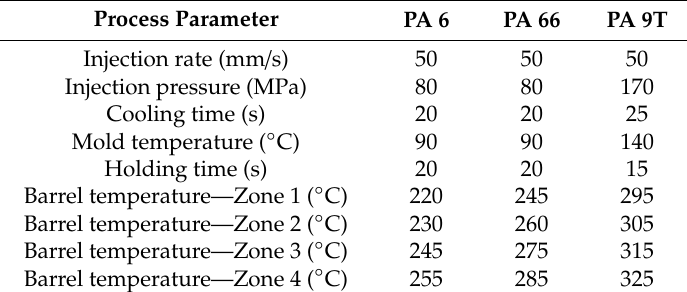
Figure 2. Test sample dimensions. Table 2. Process parameters.